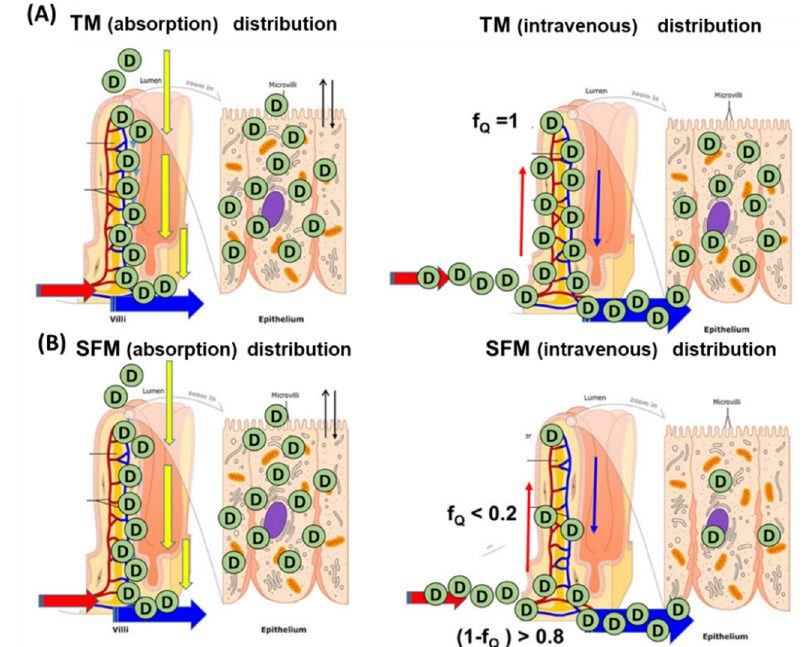
Figure 2. Schematic of drug molecules (D) traversing the intestinal membrane and entering the enterocyte for the tradtional model (TM) ( A ) and segregated flow model (SFM) ( B ). After po admininstration, the drug is absorbed into the enterocyte (yellow arrow) and distributed abundantly in the epithelisum (adjacent) for both the TM and SFM. After intravenous administration, the drug is distributed to the same extent in the epithelium according to the TM (f Q = 1) while the SFM (f Q < 0.2) predicts a much lower distribution of drug in enterocytes. This figure was reproduced with permission from Noh and Pang [18], Wiley, 2019.